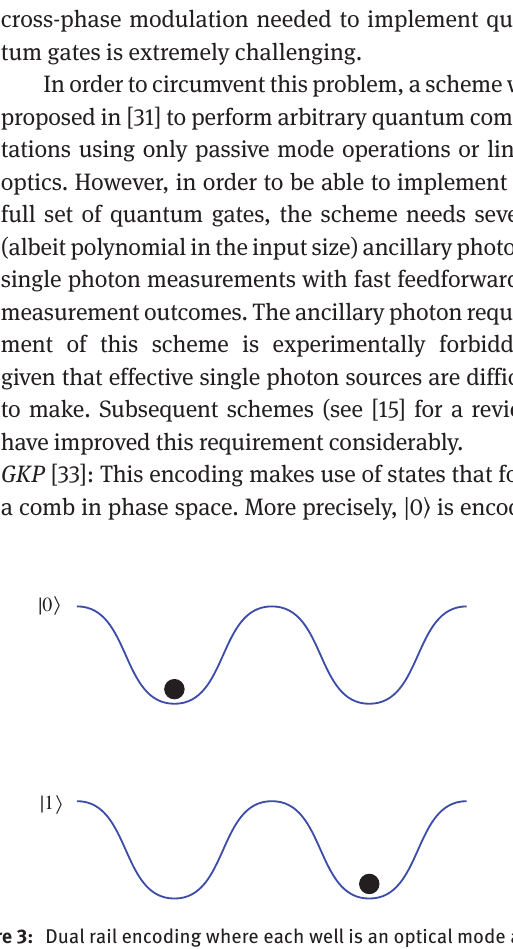
Figure 3: Dual rail encoding where each well is an optical mode and the particle is a single photon.